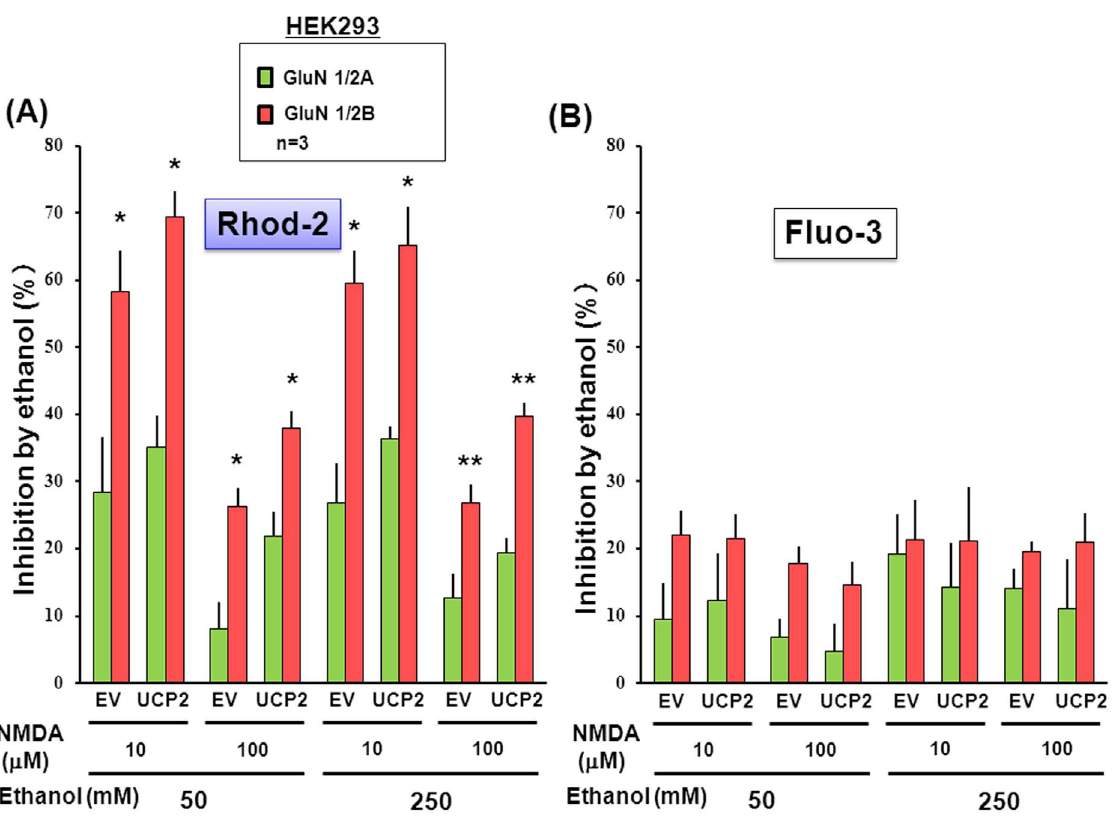
Figure 9. Comparison between inhibitions by ethanol on acquired NMDAR channels with GluN2A and GluN2B subunits. HEK293 cells were transfected with different NMDAR subunits along with Flag-UCP2, followed by further culture for an additional 24 h and subsequent loading of either (A) Rhod-2 or (B) Fluo-3. Cells were cumulatively exposed to NMDA at 0.1 to 100 m M in either the presence or absence of 50 and 250 mM ethanol. Values are percentages of the inhibition by ethanol in 3–6 independent determinations. *P , 0.05, **P , 0.01, significantly different from each control value obtained in cells with GluN2A subunit. Statistical significance was determined according to the 2-way ANOVA test analysis.